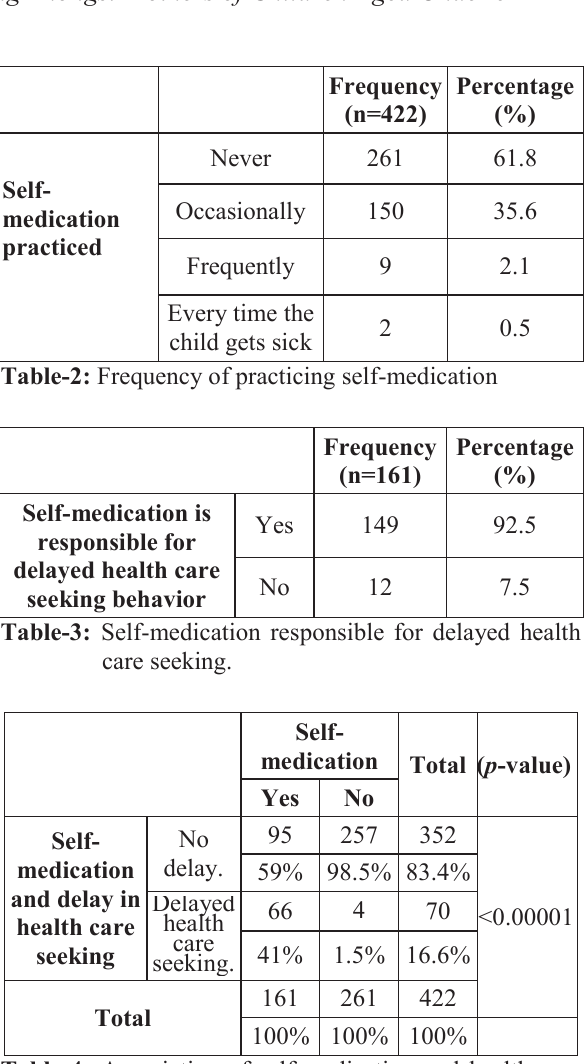
Table-4: Association of self-medication and health care seeking behavior.